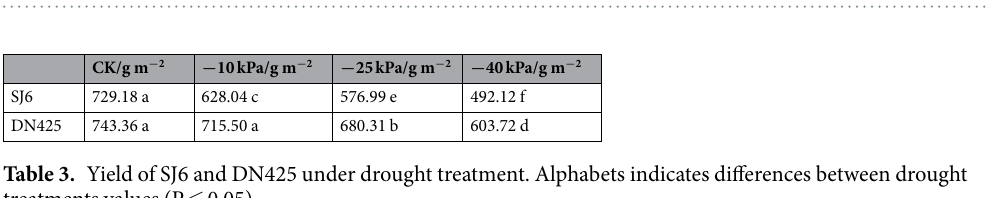
Table 2. Correlation coefficients among different indexes in leaves of rice under drought stress and recovery at tillering stage. * Significant at P < 0.05. ** Significant at P < 0.01.